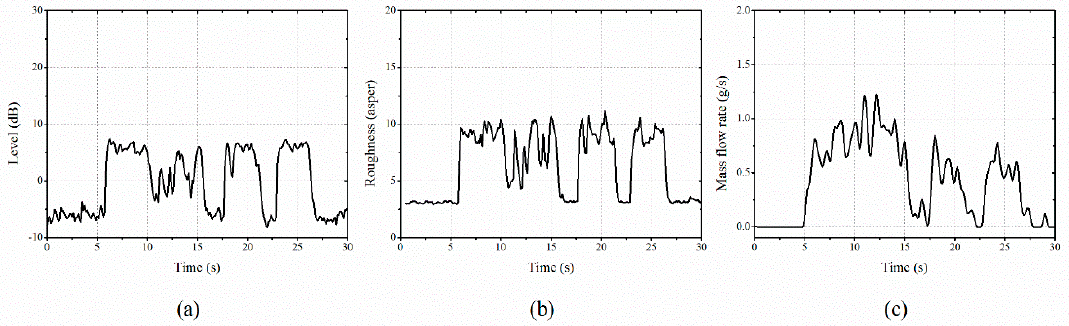
Figure 9. Comparison of the vibration signals and mass flow rate: ( a ) vibration level, ( b ) roughness, and ( c ) mass flow rate.